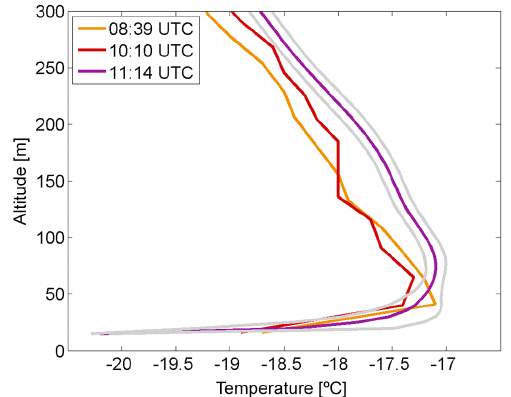
Figure 7. Vertical temperature profiles measured by RS92 ra- diosondes launched from Ny-Ålesund on 20 March 2015. The ra- diosonde launched at 11:14UTC has been processed as a GRUAN reference sonde, and the corresponding temperature profile (pur- ple line) is provided with measurement uncertainty in each altitude level (grey